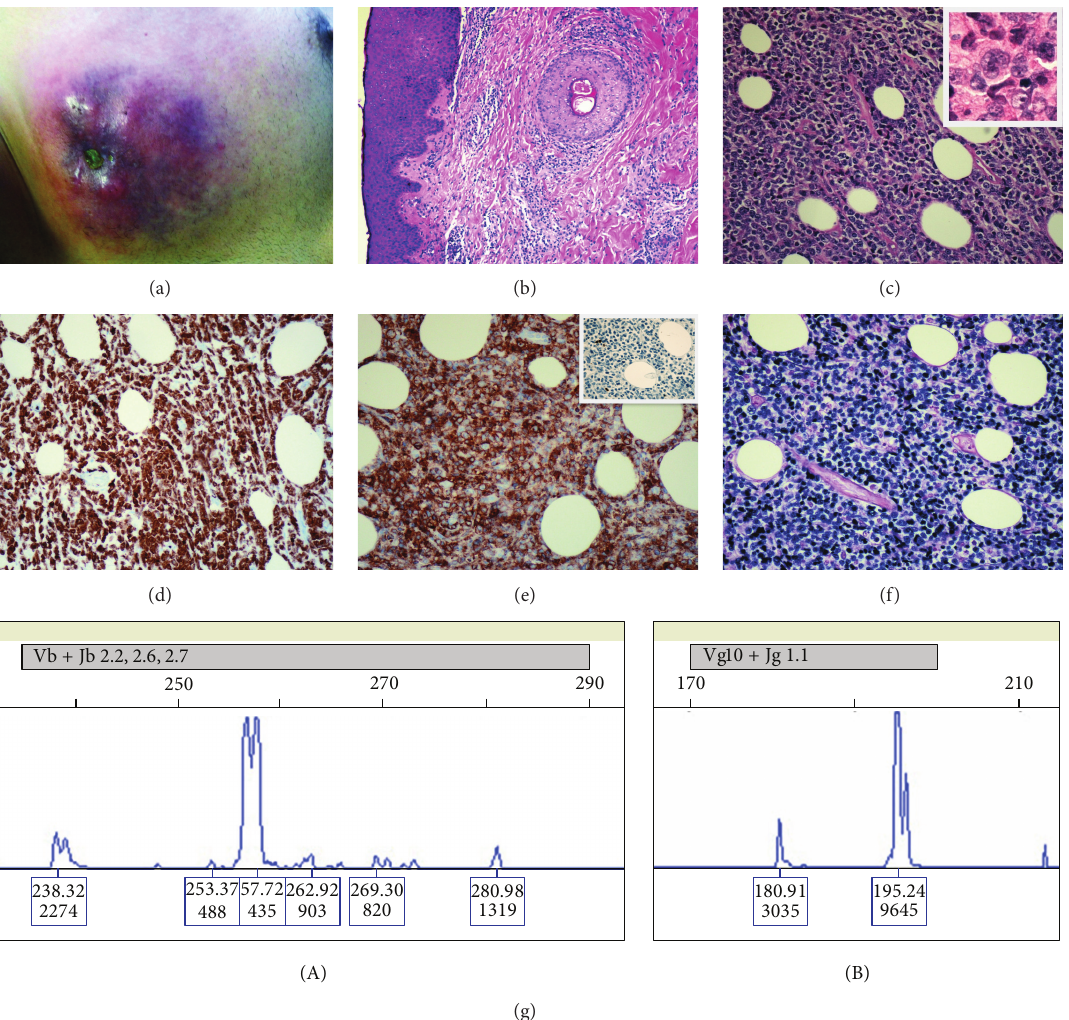
Figure 1: (a) Chest wall subcutaneous mass that rapidly enlarged in size. Epidermal scab is after incisional biopsy. (b) H&E showing uninvolved epidermis (10x). (c) H&E of the lesion with large neoplastic cells rimming the subcutaneous adipose tissue (20x). Inset shows scattered neoplastic cells with “hallmark cell” morphology. (d) and (e) Immunohistochemical stains strongly positive for CD3 and CD30, respectively (20x). Inset (e) shows a negative TIA1 stain in tumor cells with scattered positive cells corresponding to reactive CD8+ T-cells. (f) In-situ hybridization for Epstein-Barr virus encoded early RNA with diffuse strong expression in the tumor cells. Endothelial cells on a blood vessel seen here are negative (20x). (g) Positive T-cell receptor gene rearrangement: (A) TCR- 𝛽 and (B) TCR- 𝛾